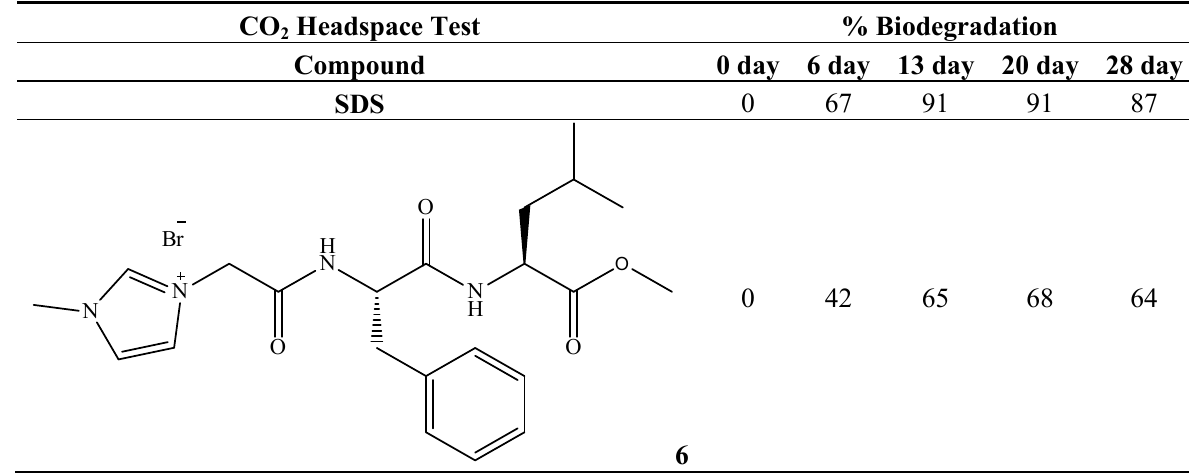
Table 4. Biodegradation data for amino acid derived ILs ( 6 ) and SDS internal standard. ( 6 ) is classed as readily biodegradable (ISO